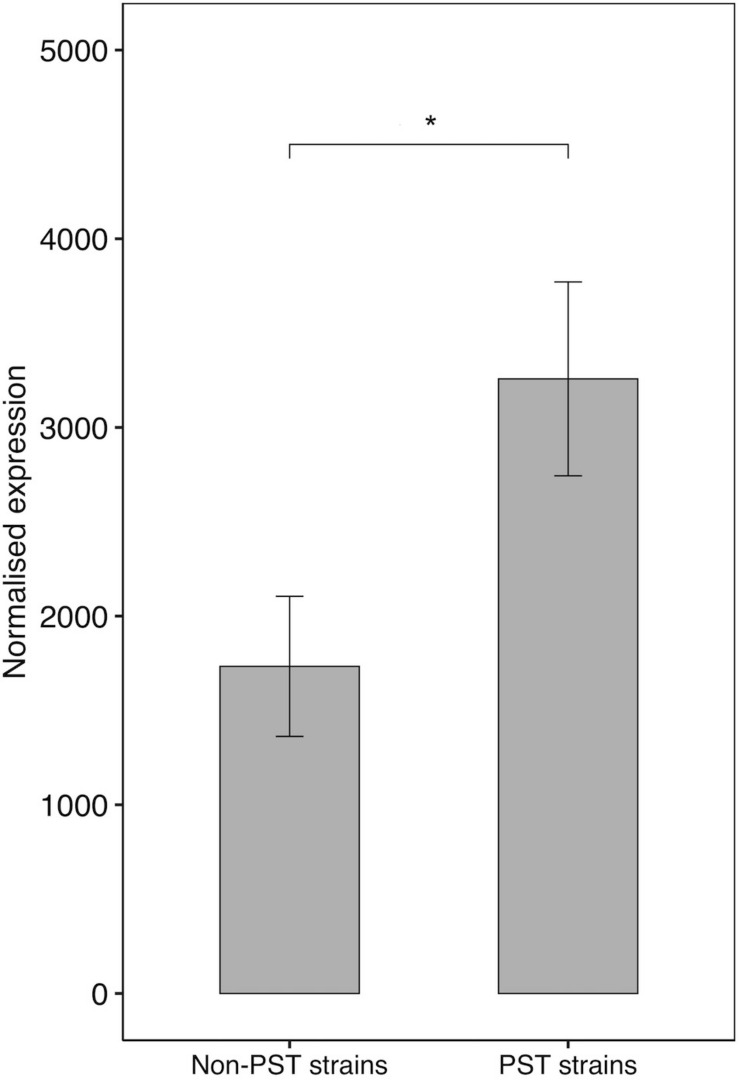
SxtA4 normalized expression (from comp112540_c0_seq1) in the non-PST producing A. minutum strains (RCC2644 and RCC2645) and the PST-producing A. minutum strains (RCC3327, RCC7038, CH940x, RCC3167, RCC7037, RCC4871, RCC7039, RCC4872, and RCC4890). T-test, *p < 0.05. Error bars represent the standard deviations.